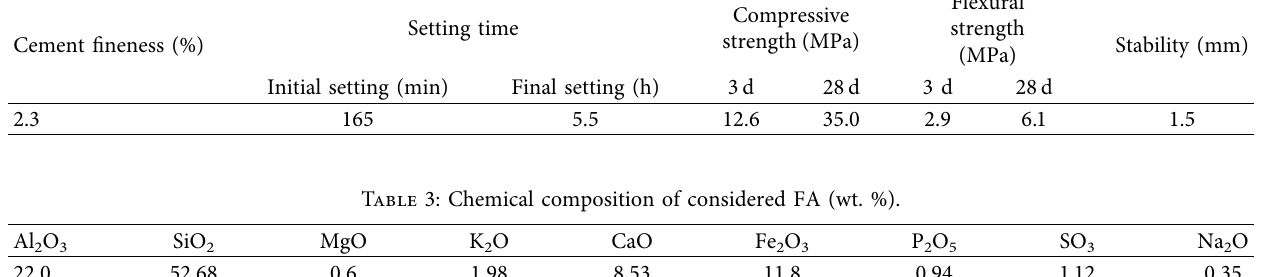
Table 4: Physical properties of fine aggregate. Fineness